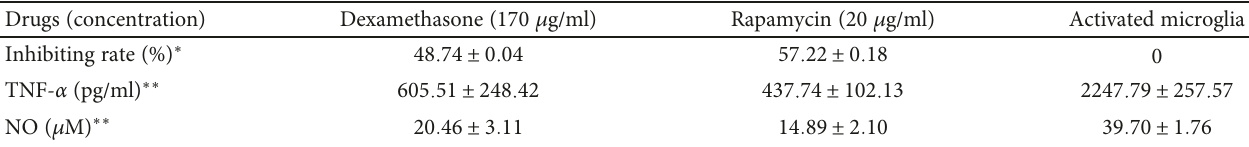
Table 2: Rapamycin and dexamethasone suppressed